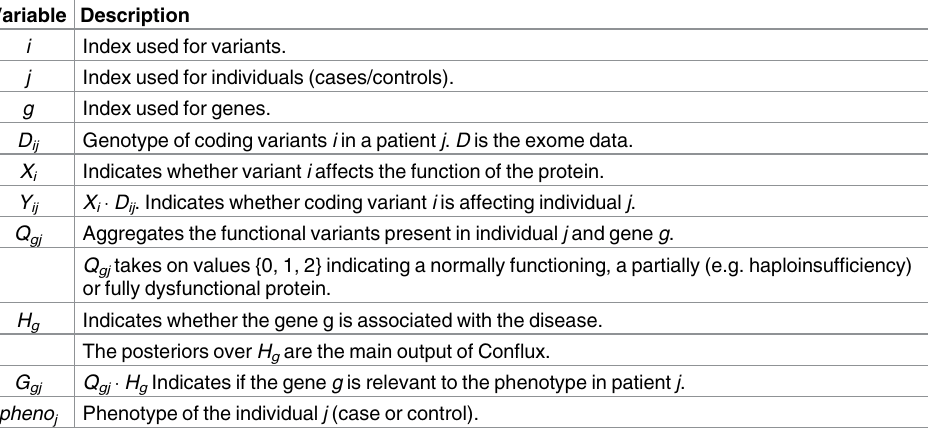
Table 1. Description of the variables in the model. pheno and D are fixed inputs. All other variablesare latent random variablesto be inferred. Variable